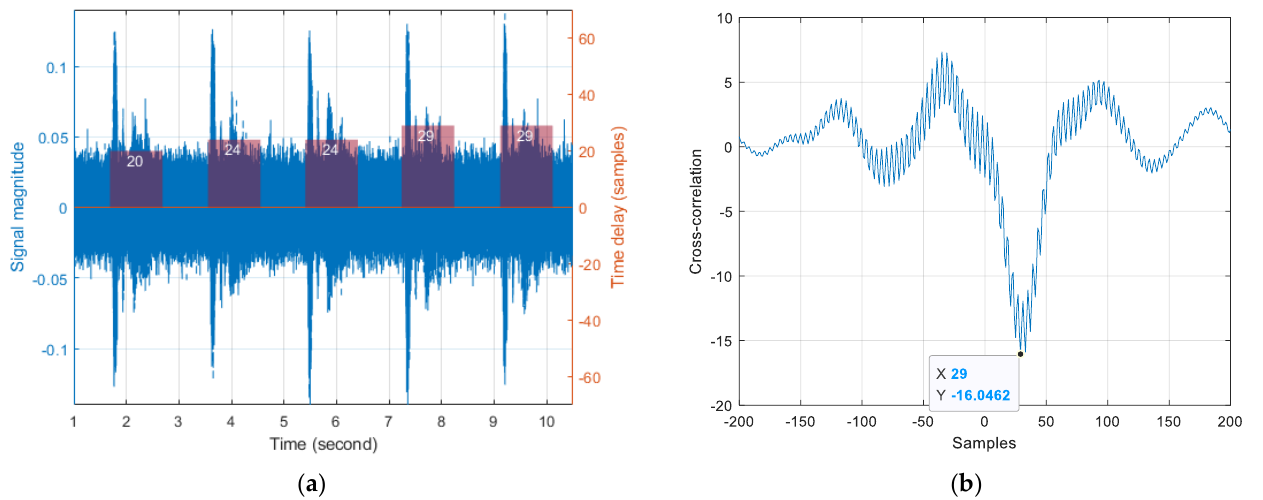
Figure 22. Signal and measured time delay distribution for 5.0 m and 30 ° configuration: ( a ) Signal magnitude in blue with left axis and measured time delay in transparent purple with right axis; ( b ) One output of cross-correlation.